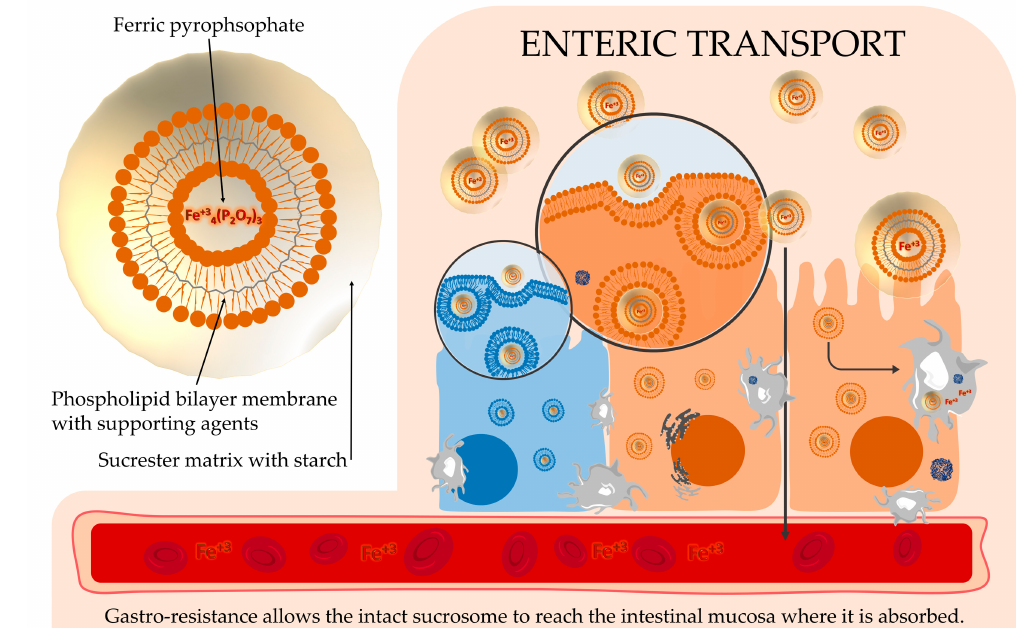
Figure A1. Schematics of the formula that was used in the research study and the suggested mechanisms of intestinal absorption. Absorption starts with passive transport by enterocytes or specialized epithelial cells of the mucosa-associated lymphoid tissues (M cells), and concludes with macrophage degradation and